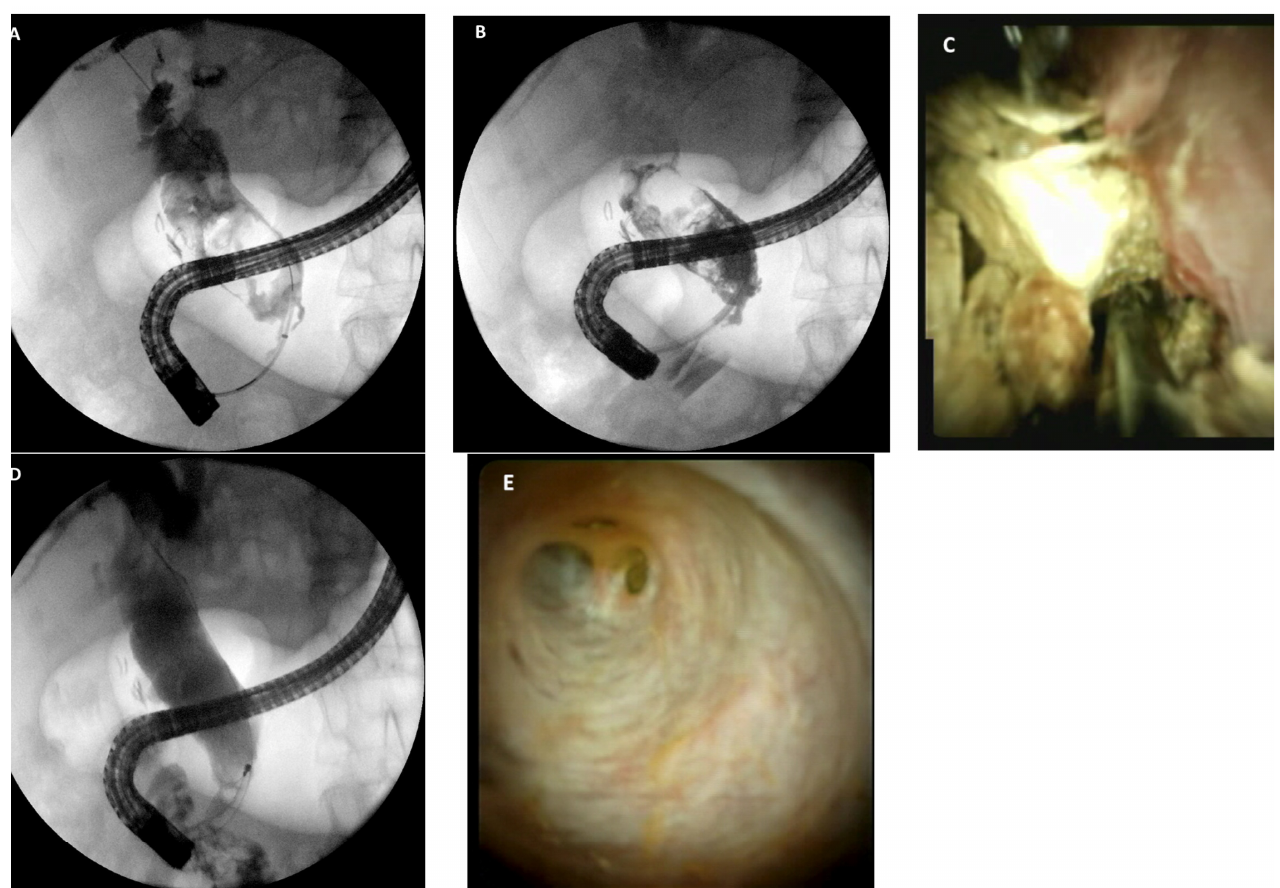
Figure 3. ( A ) cholangiogram showing a large common bile duct stone; ( B ) fluoroscopic image of the cholangioscope in the common bile duct during lithotripsy; ( C ) cholangioscopic view of intraductal lithotripsy with electro-hydraulic probe; ( D ) final cholangiogram showing clearance of the bile duct after lithotripsy and extraction of fragments; ( E ) cholangioscopy showing clearance of the bile